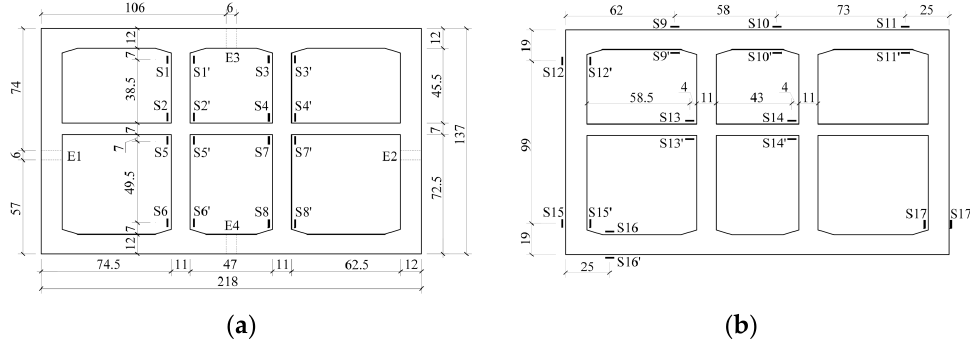
Figure 4. Layout of strain sensors in cross-section of the model. ( a ) Major observation section; ( b ) secondary observation section (unit mm).